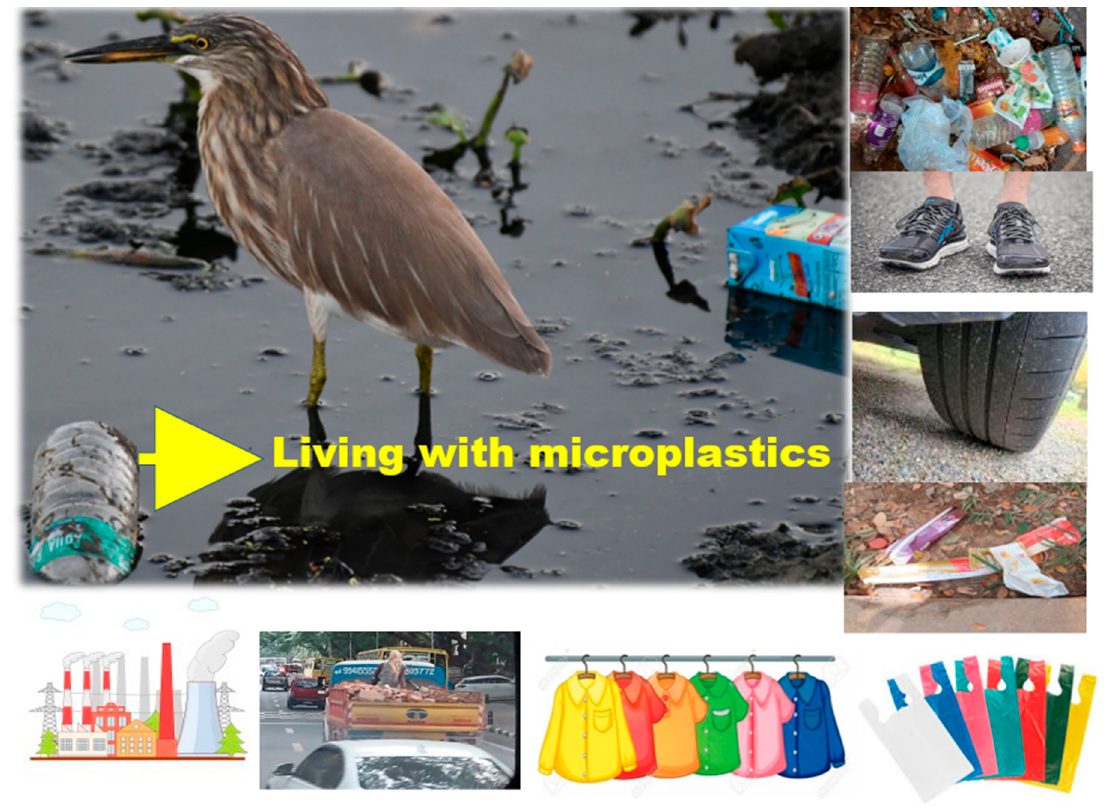
Figure 1 . Sources of microplastics. Figure 1. Sources of